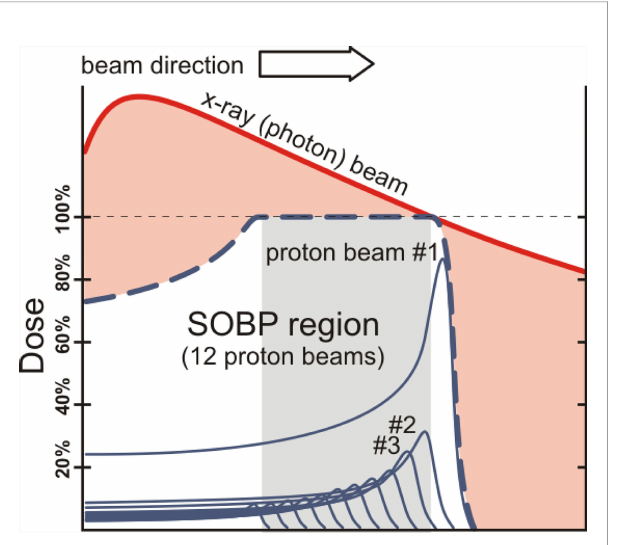
FIGURE 2 | Relative dose versus depth from the body surface for photon- and charged-particle radiation – after (14).